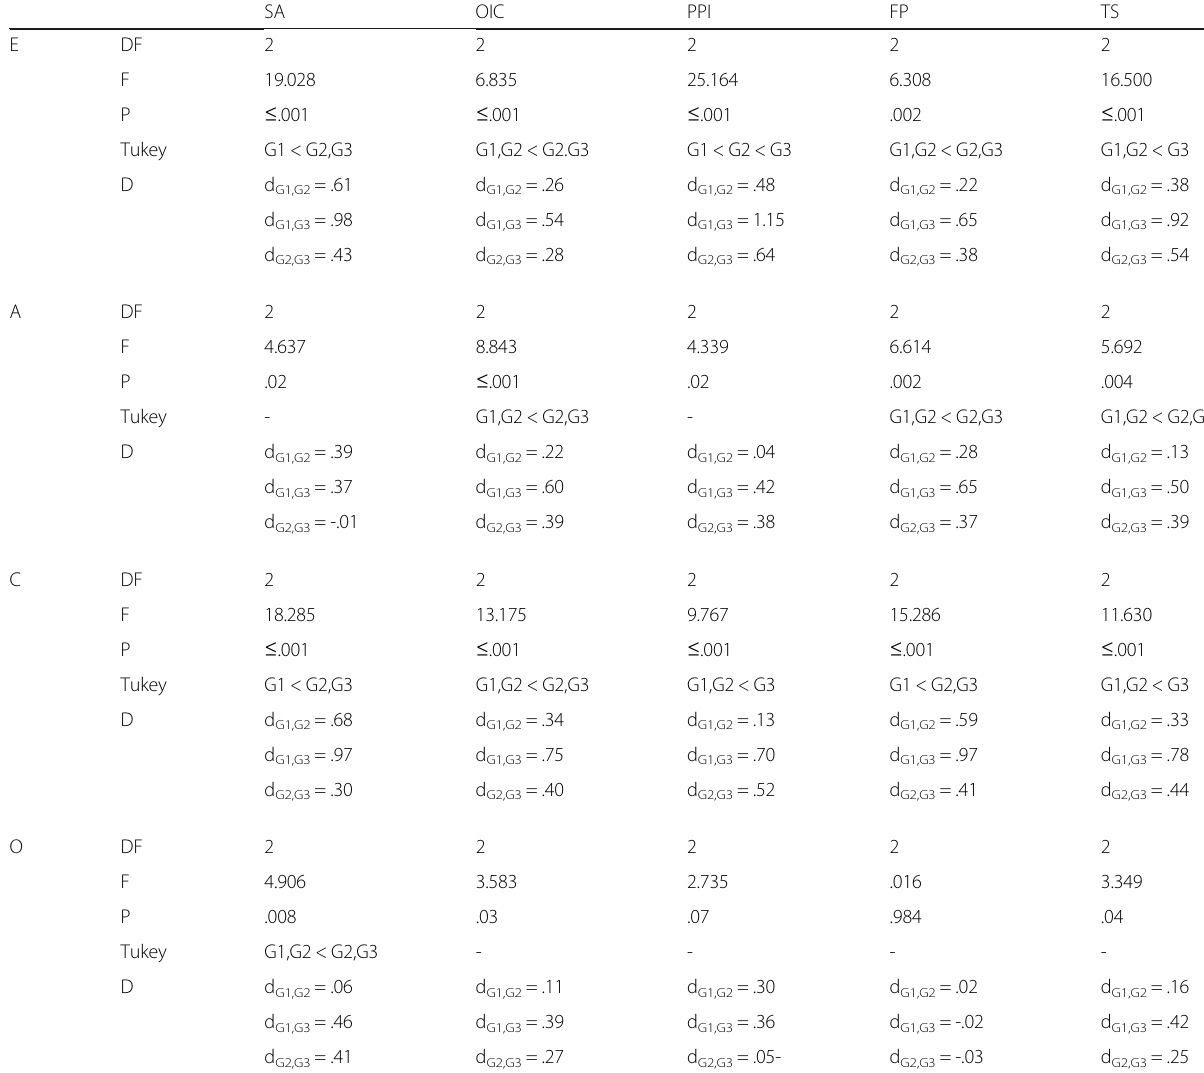
Table 2 Variance analysis (ANOVA) of personality factors considering the groups with different levels of self-efficacy SA